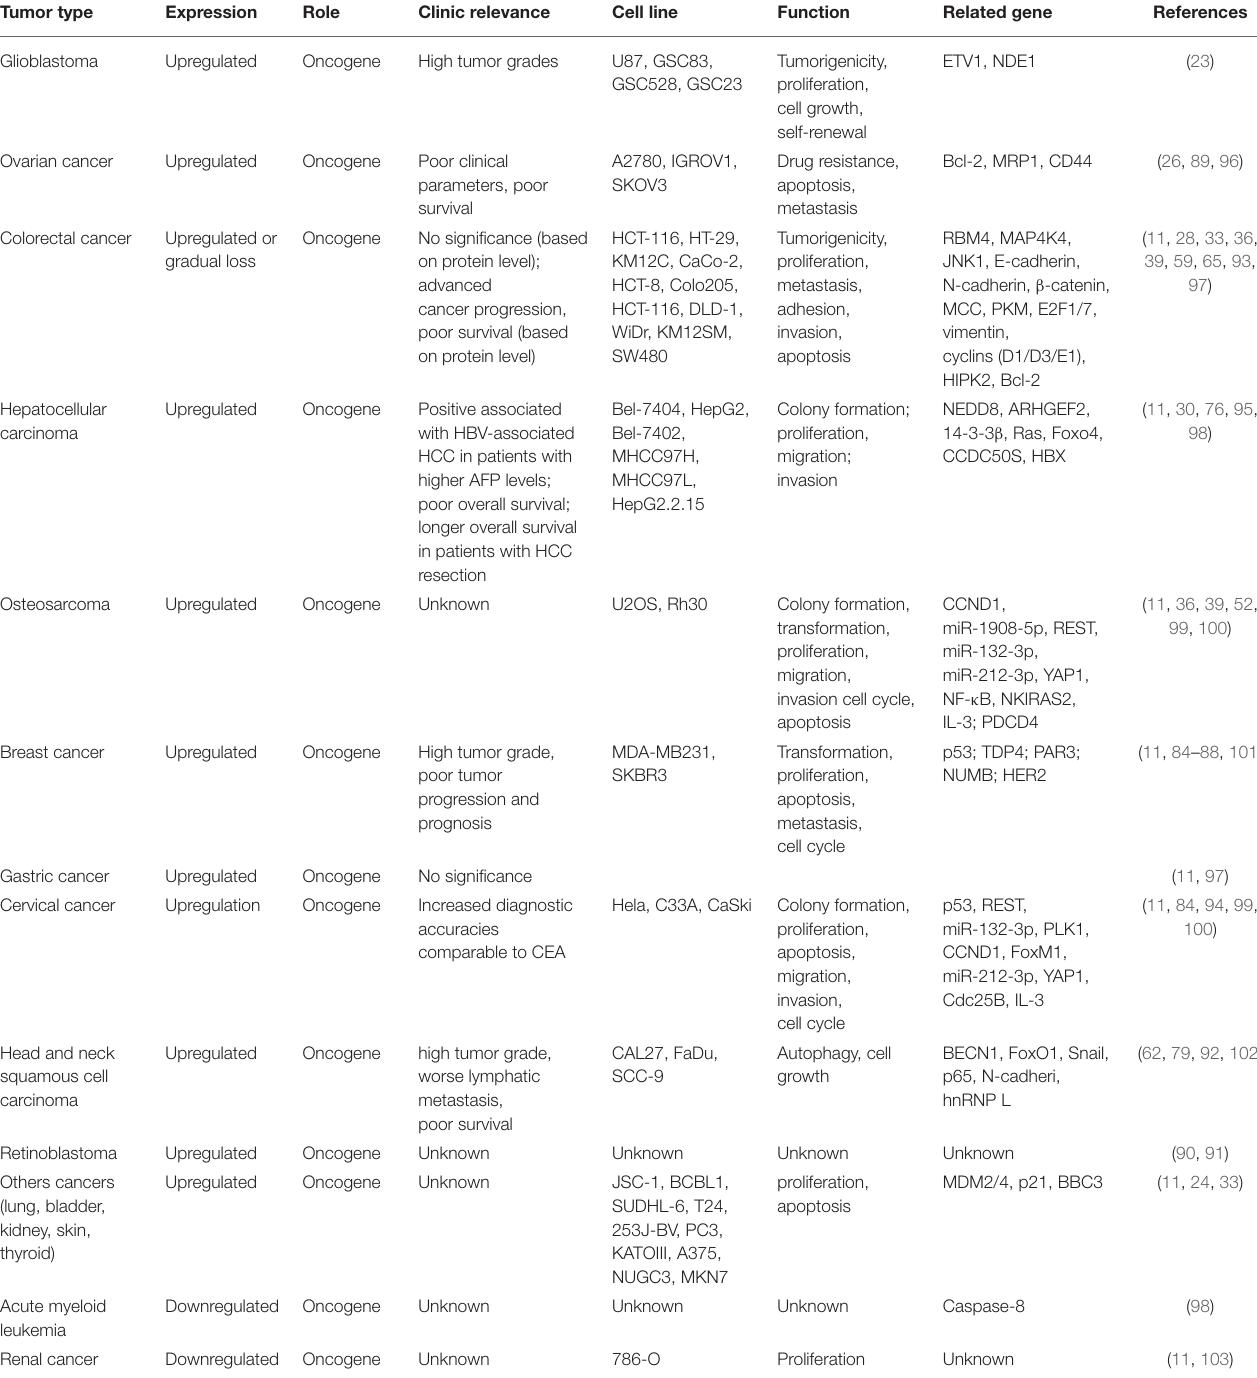
TABLE 1 | Clinical features, cell functions and related genes associated with upregulation of SRSF3 in human